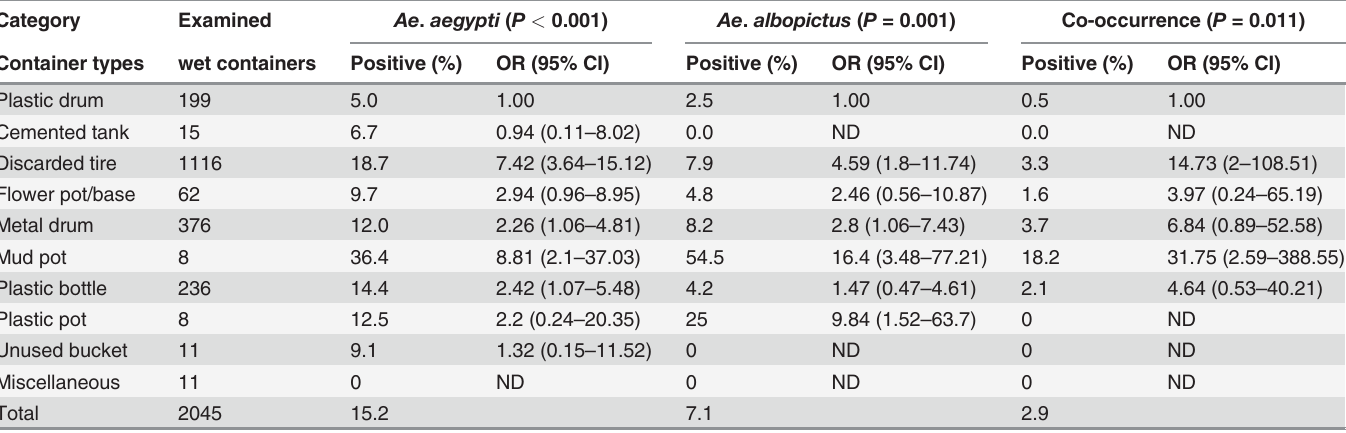
Table 2. Container types associated with the presence of immature stages of Aedes aegypti , Aedes albopictus and their co-occurrence in central Nepal. Category